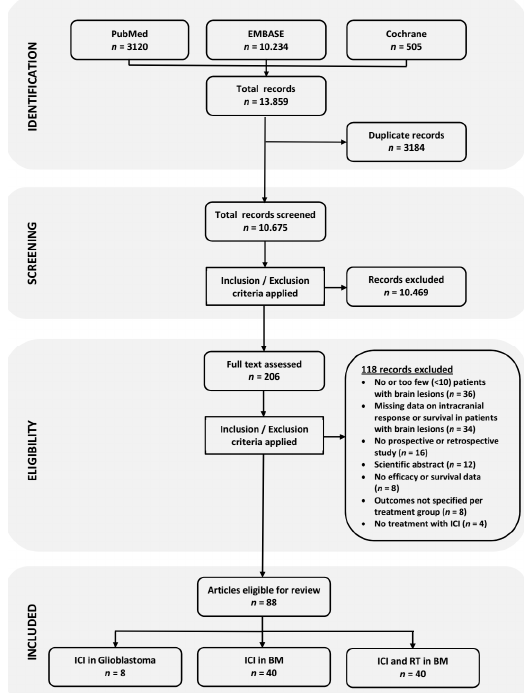
Figure 1. Flow diagram illustrating the literature search and study selection.